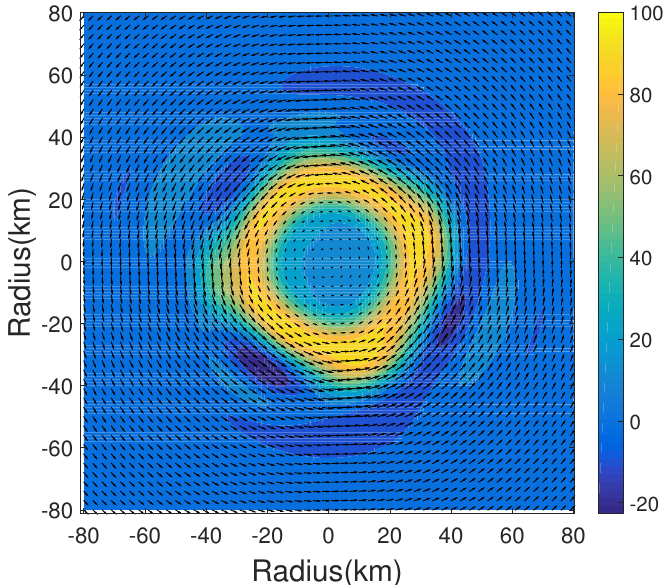
Figure 1. The normalized vorticity (shaded) and horizontal winds (arrows) of a sample vortex. The vorticity field was normalized by the maximum vorticity (2.64 × 10 − 3 ) s − 1